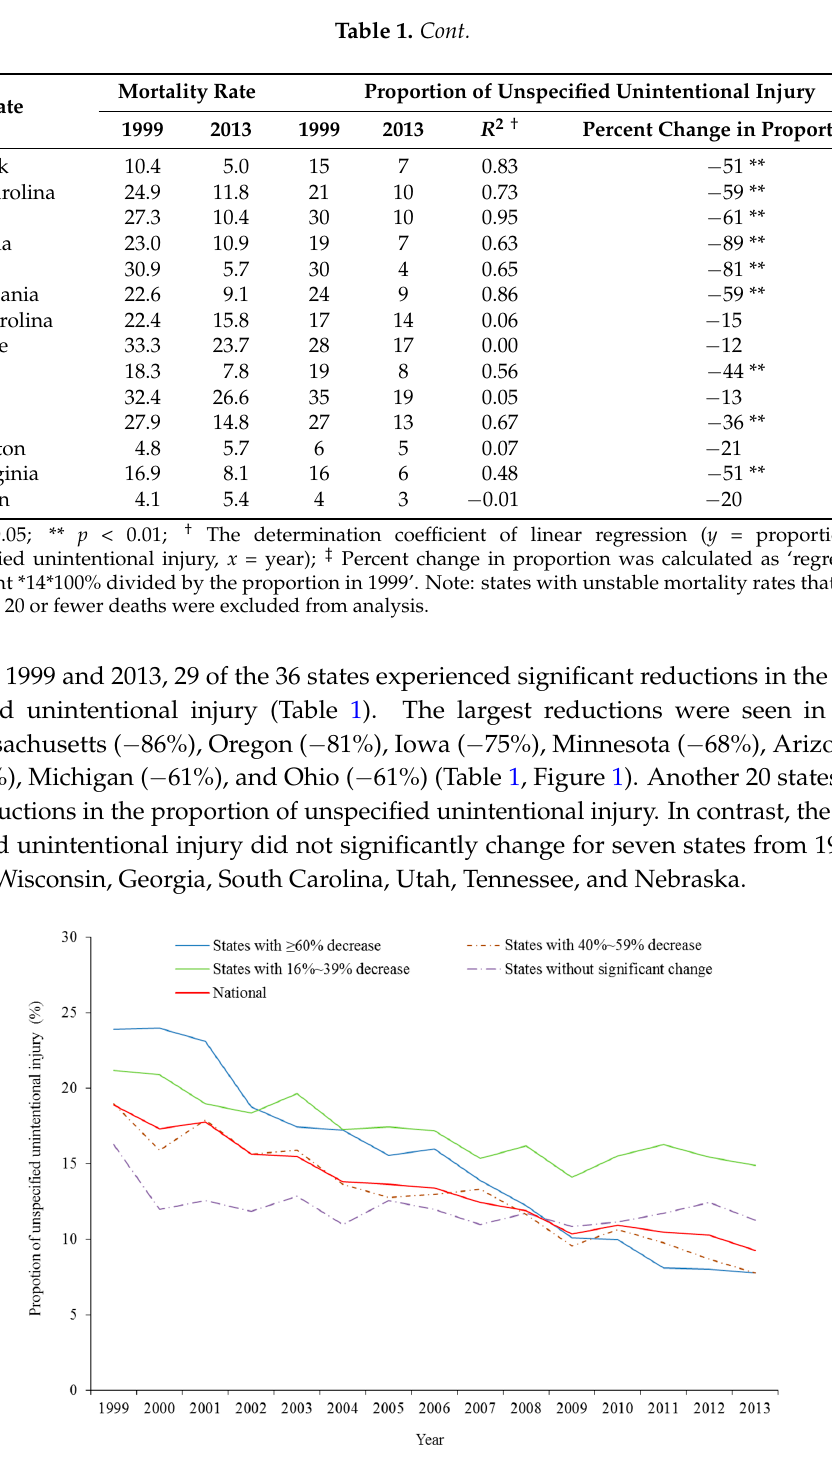
Figure 1. Proportion of unspecified unintentional injury between 1999 and 2013 among Americans aged 65+ by the extent of change. Note: (1) States with ≥ 60% decrease: Oklahoma,